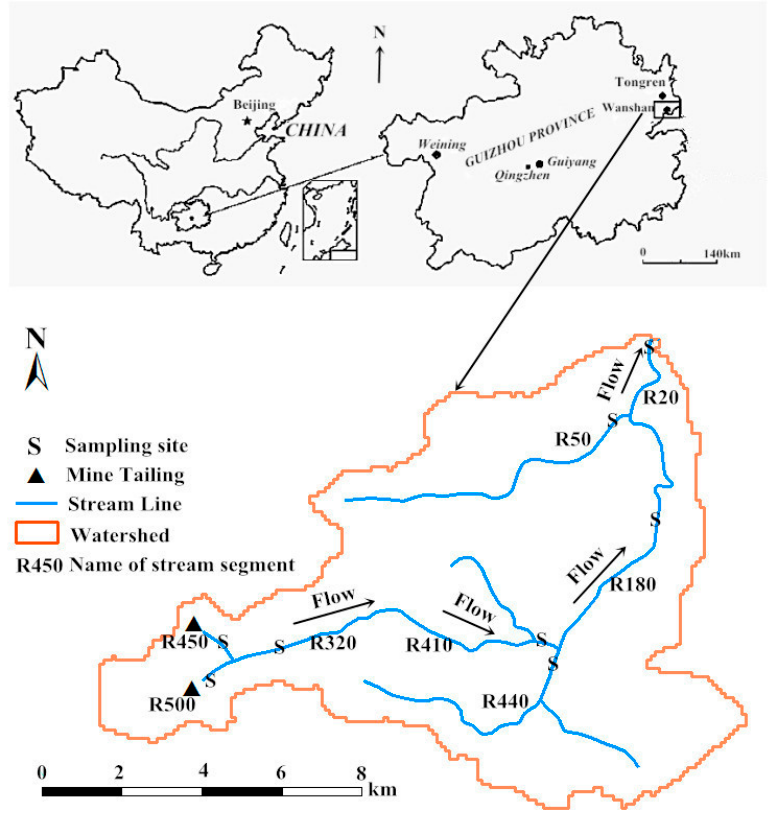
Figure 9. Map of the Xiaxi River watershed and sampling sites.